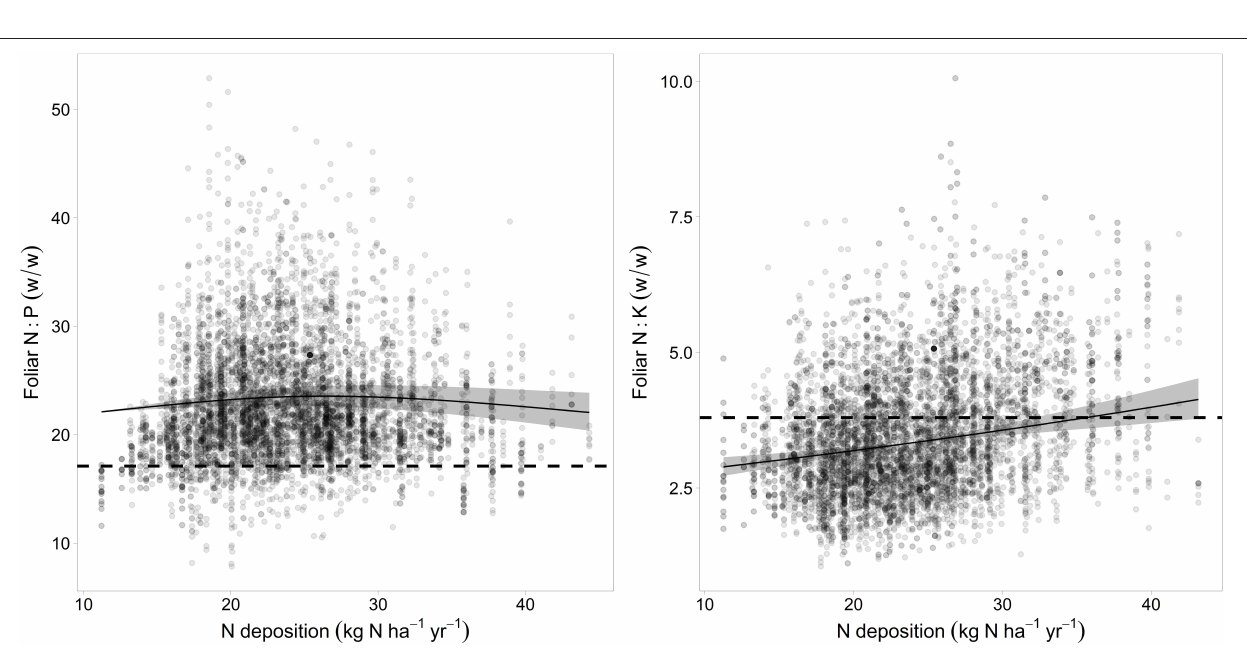
FIGURE 5 | Relation between N deposition and the N:P ratio (left) and N:K (right). The upper limit for harmonic ratios according to Flückiger and Braun (2003) are given as dotted lines. The gray bands indicate the 95% confidence interval.